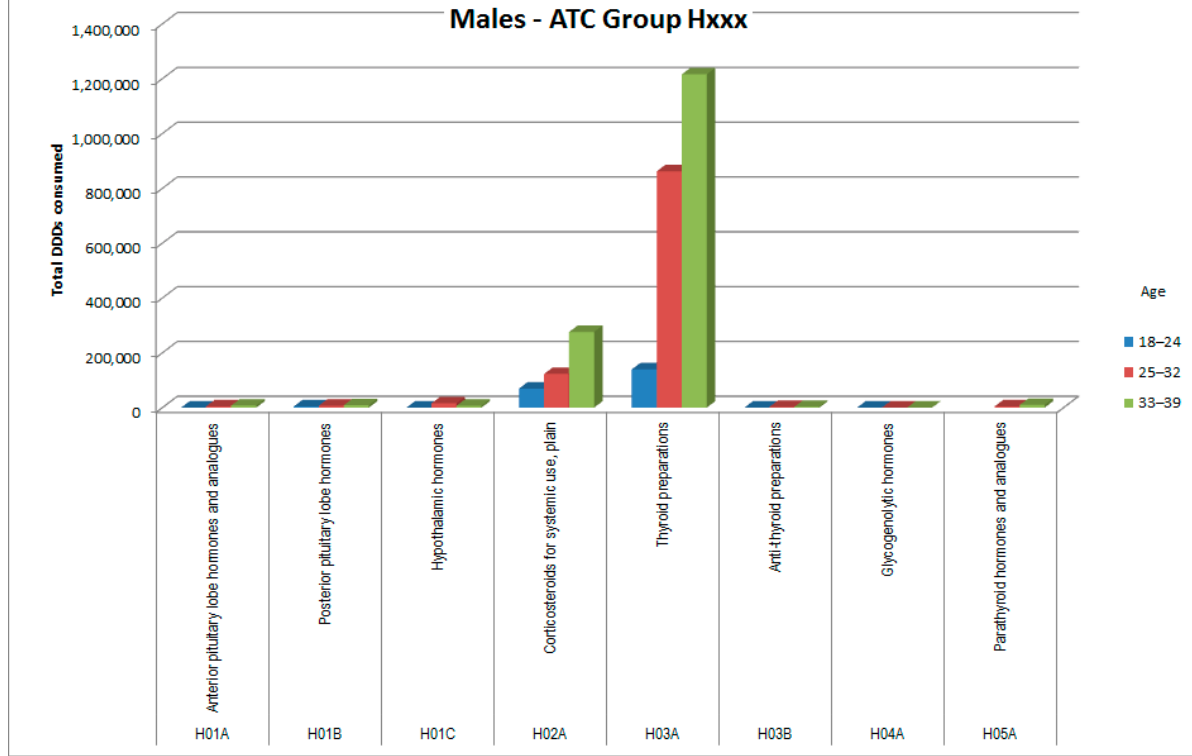
Figure 12. DDD consumption for males, ATC group Hxxx.